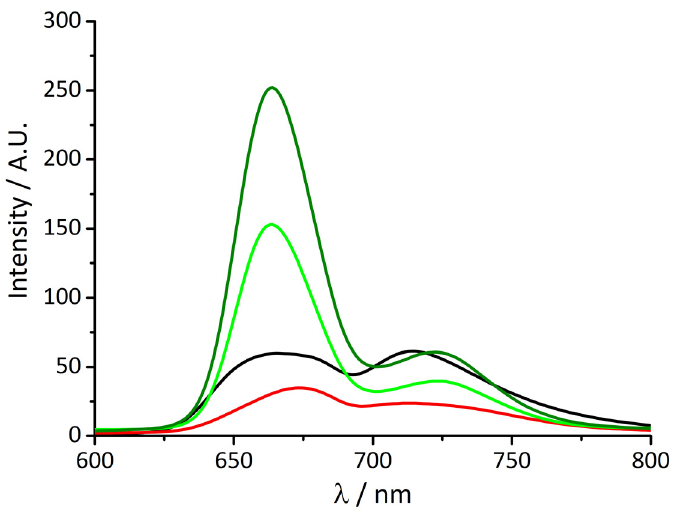
Figure 5. Fluorescence emission spectra of t-H 2 Pagg no salt added (black curve), t-H 2 Pagg aggregates (red curve), after addition of HSA at t = 0 s (light green curve) and at t = 60 min (dark green curve). Experimental conditions: [t-H 2 Pagg] = 5 μ M, [NaCl] = 100 mM, [HSA] = 100 μ M, phosphate buffer 1 mM, pH = 7.4, T = 298 K, λ EX = 438 nm (the intensity of the emission spectra have been corrected for the absorbance of the samples).